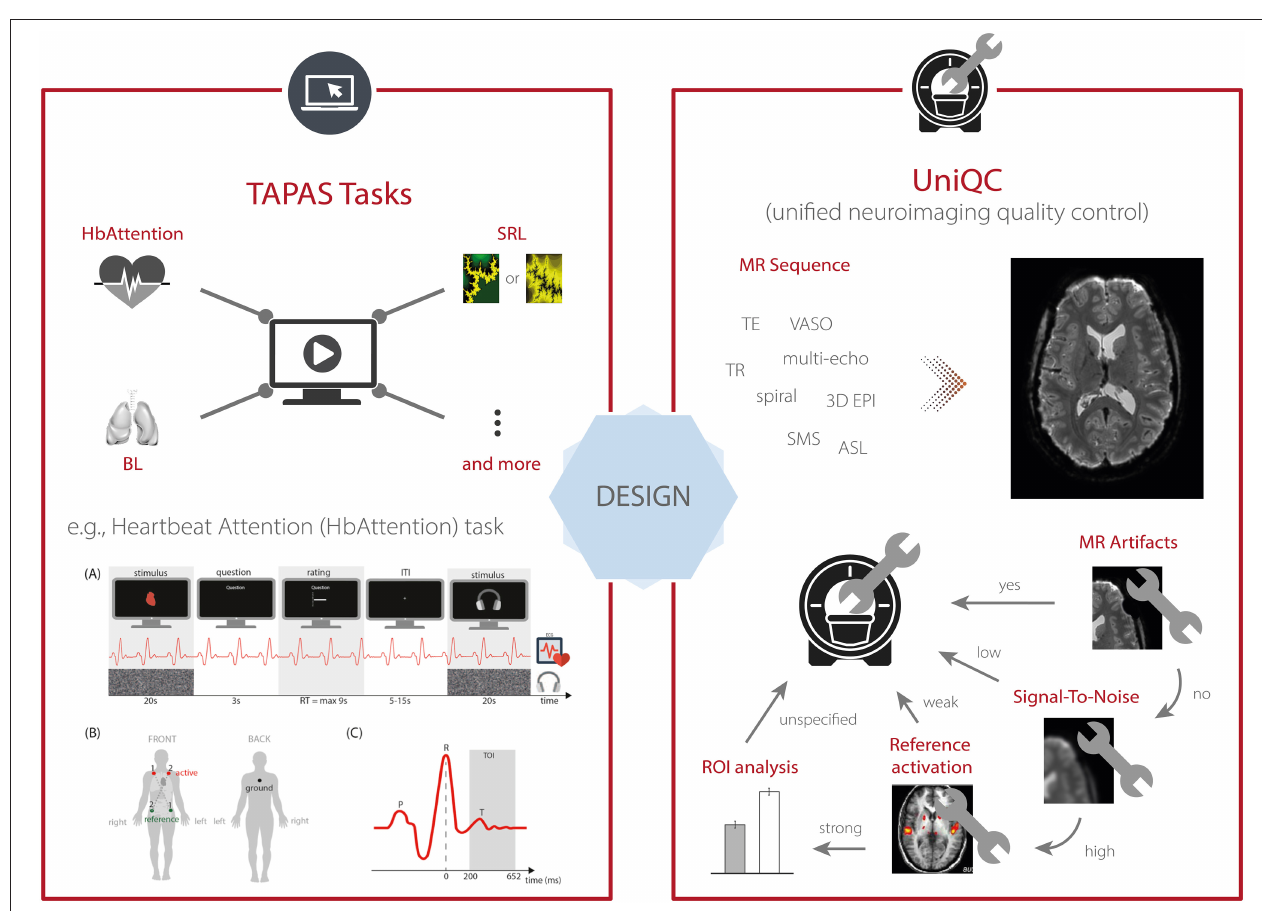
FIGURE 3 | TAPAS components that aim to enhance data quality for scientific and clinical applications. This includes ( left, top ) TAPAS Tasks, a collection of experimental paradigms that have been devised and carefully tested, for instance, the Heartbeat Attention (HbAttention), stimulus-reward learning (SRL), and breathing learning (BL) task. For a complete list of tasks that are already included in TAPAS Tasks or will be included in one of the upcoming releases, see Table 1 . ( Left, bottom ) Schematic overview of the experimental paradigm of the HbAttention task, as well as the placement of ECG electrodes and a typical ECG signal associated with a heartbeat [reprinted with permission from Petzschner et al. ( 47)]. ( Right ) Furthermore, TAPAS comprises the unified neuroimaging quality control (UniQC) toolbox which is designed to facilitate the development and optimization of MR acquisition sequences. UniQC can assess (compute and visualize) different image quality metrics (IQMs) at different stages of an fMRI experiment (i.e., from raw data to statistical images). This facilitates the acquisition of high-quality data by implementing an iterative optimization process, including basic artifact checks, temporal stability analysis, functional sensitivity analyses in the whole brain or in particular regions of interest. UniQC enables this optimization in a highly flexible fashion, independent of the exact input data (e.g., sequence,